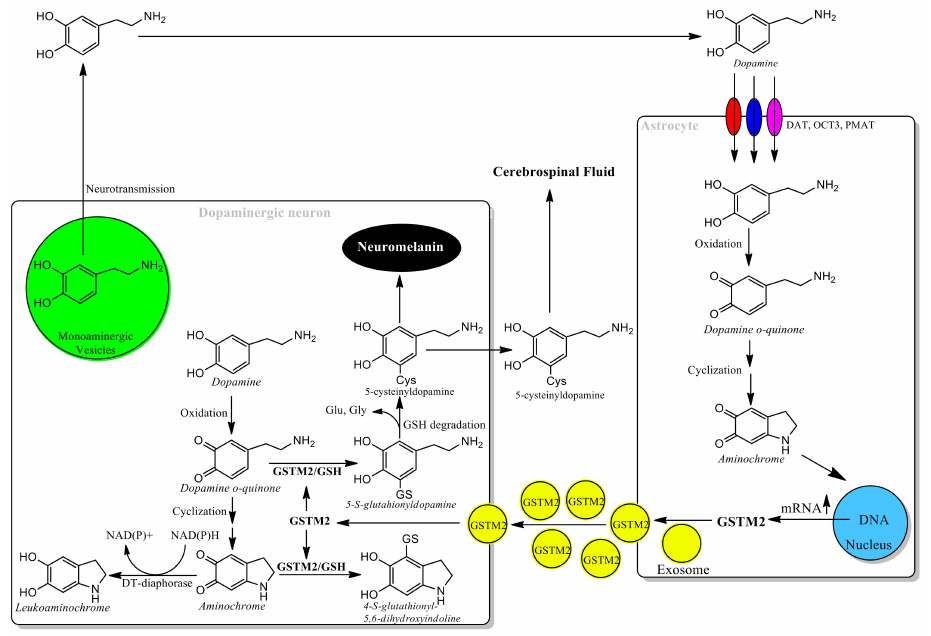
Figure 5. Astrocytes protects dopaminergic neurons against aminochrome neurotoxicity. A new mech- anism of neuroprotection of dopaminergic neurons against the neurotoxic effects of aminochrome mediated by astrocytes has been reported. Dopaminergic neurons express DT-diaphorase to pre- vent aminochrome neurotoxic effects. Dopamine neurons release dopamine normally during the neurotransmission process, which astrocytes are also able to take up through transporters that are expressed in astrocytes such as dopamine transporter (DAT), organic cation transporter-3 (OCT3), and plasma membrane monoamine transporter (PMAT). Dopamine within astrocytes can be oxidized to form aminochrome, which increases the expression of glutathione transferase M2-2 (GSTM2). GST M2-2 prevents the neurotoxic effects of aminochrome within astrocytes by conjugating it with glutathione, but GST M2-2 is also exported through exosomes that are released from astrocytes into dopaminergic neurons. Exosomes loaded with GST M2-2 penetrate dopaminergic neurons, releasing this enzyme into the cytosol of these neurons, where together with DT-diaphorase they prevent the neurotoxic effects of